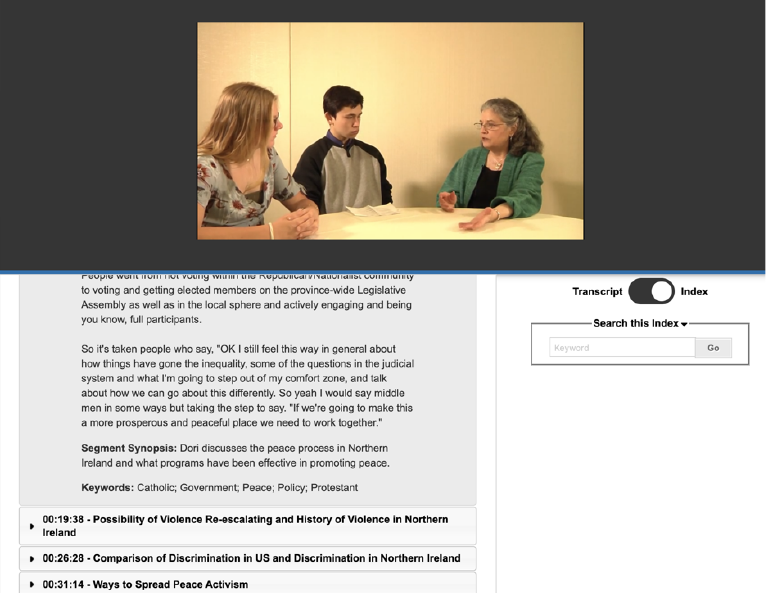
FIGURE 2. DETAIL IMAGE OF THE INTERVIEW ABOVE. NOTE HOW OHMS ALLOWS THE STUDENTS TO INCLUDE THE TRANSCRIPT, SEGMENT SYNOPSIS, AND KEYWORDS.